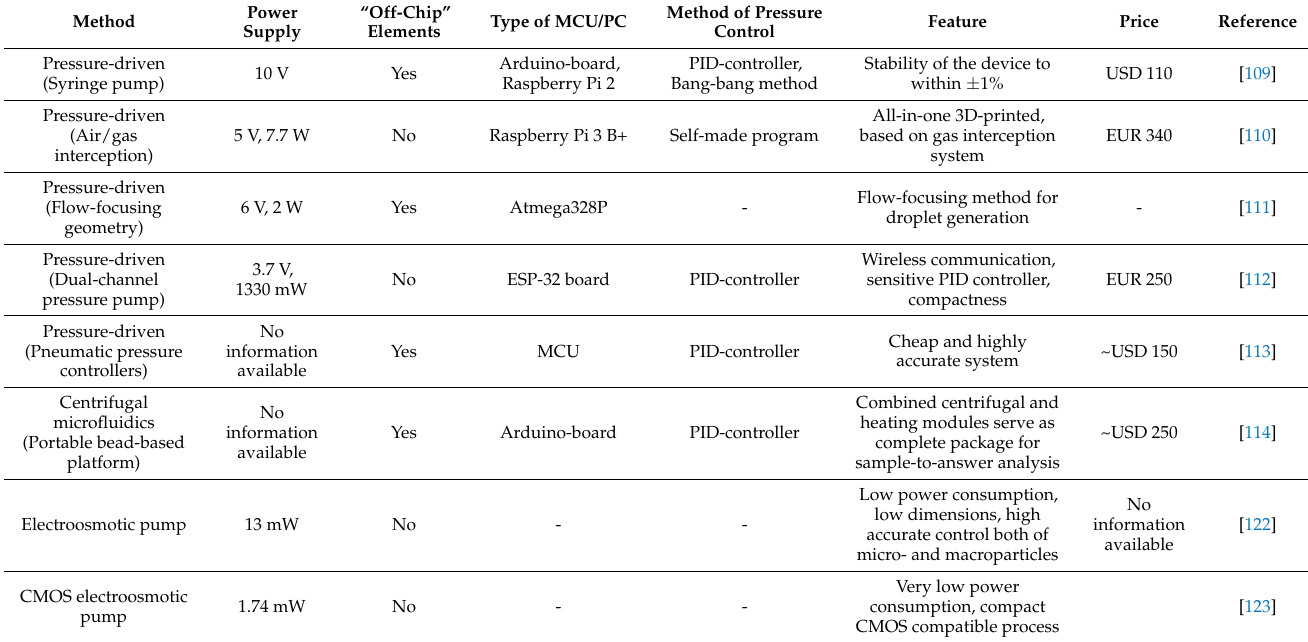
Table 1. Comparison of active pumping techniques for microfluidic